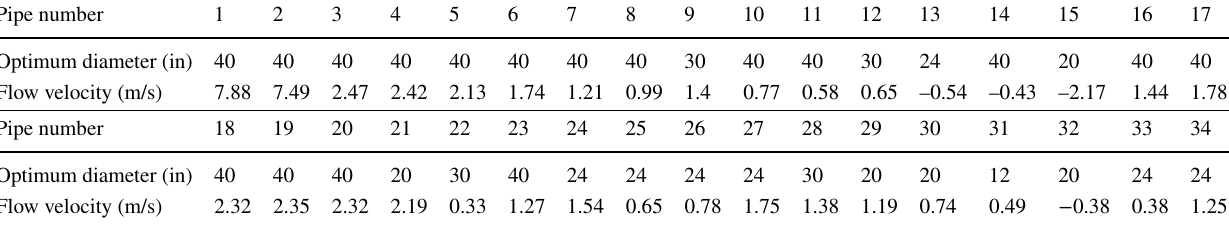
Table 8 Optimal diameter calculated by the NSGA-II model for three-loop pressure-dependent leakage Hanoi WDN Pipe number